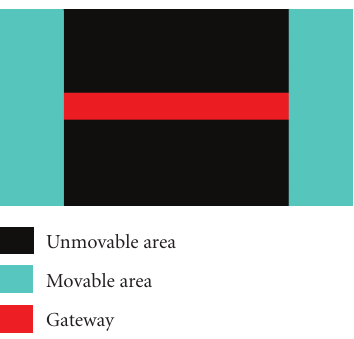
Figure 4: Illustration of a gateway.